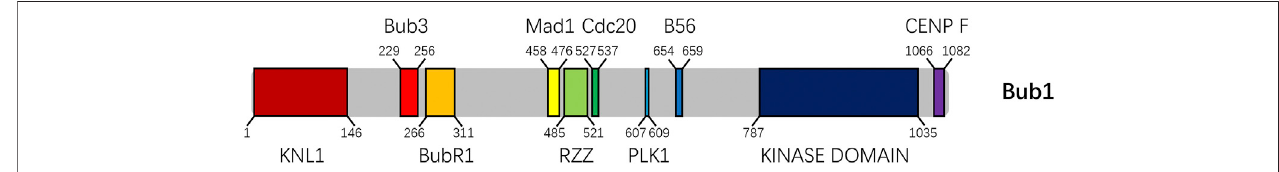
FIGURE1| SchematicofthedomainsonhumanBub1protein.Fromlefttoright,thedomainsinteractingwithKNL1,Bub3,BubR1,Mad1,RZZ,Cdc20,Plk1,B56 (putative)andCENP-Faremarkedwithreportedboundaries.Thekinasedomainisalsoshown.Thenumbersbeloworabovetheschematicindicatethestartandendof the